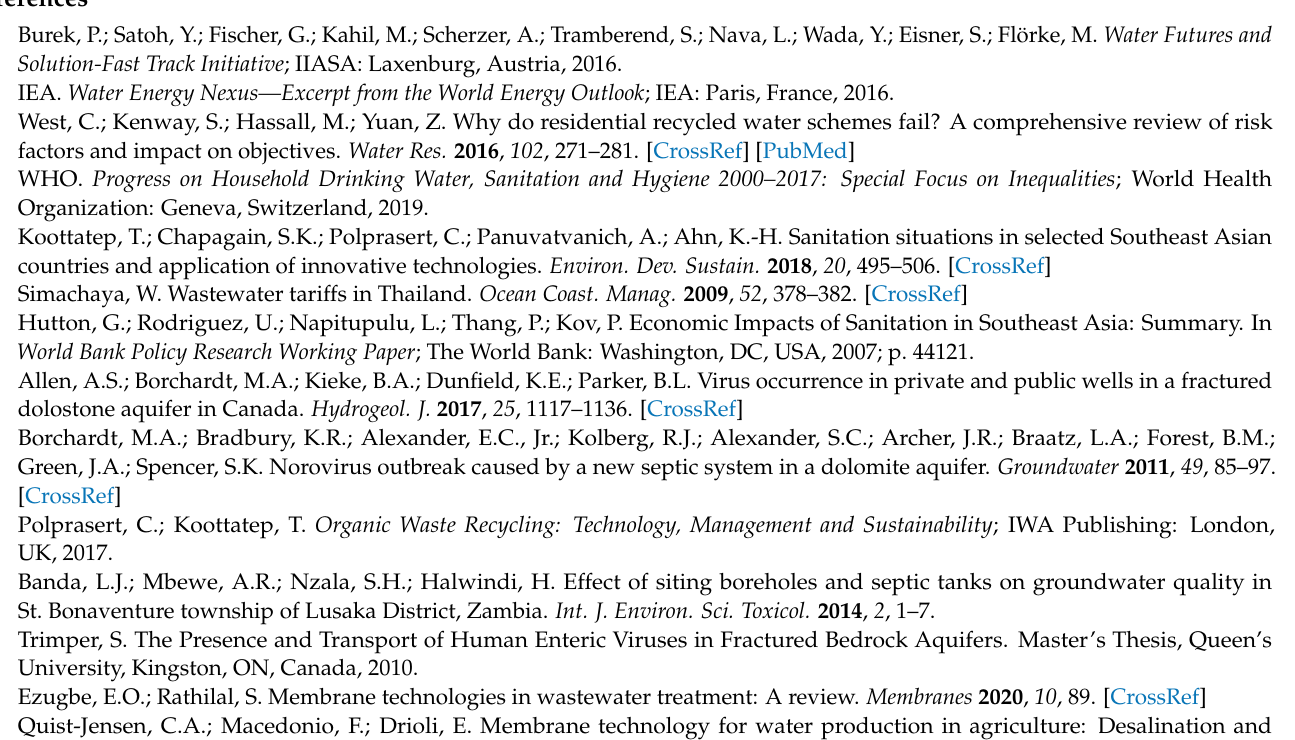
effluent, Figure S3: Measured (dots) and predicted (solid lines) RED as a function of the UV LED system flow rate and